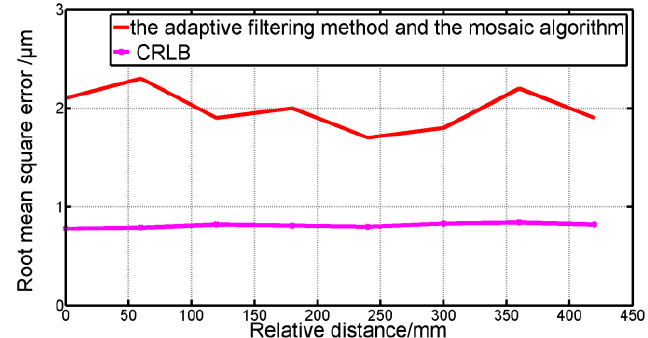
Figure 10. Comparison of the measured root mean square error with the CRLB.